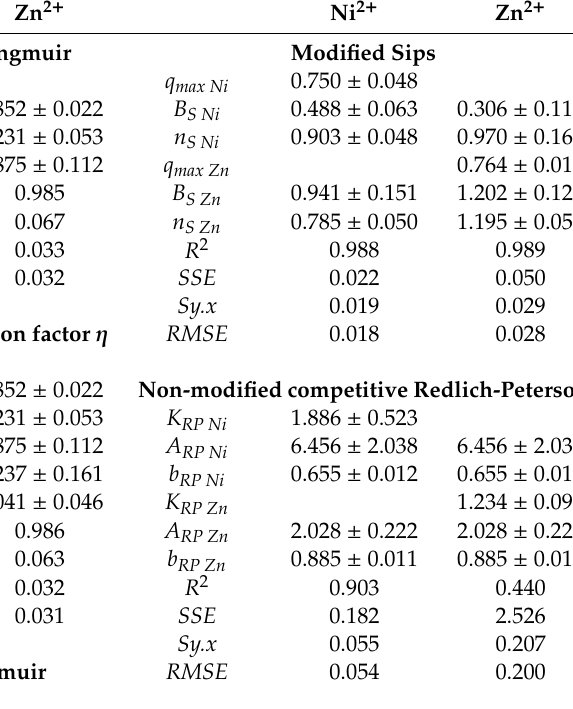
Table 6. Isotherm model parameters for Ni 2 + and Zn 2 + biosorption in binary metal